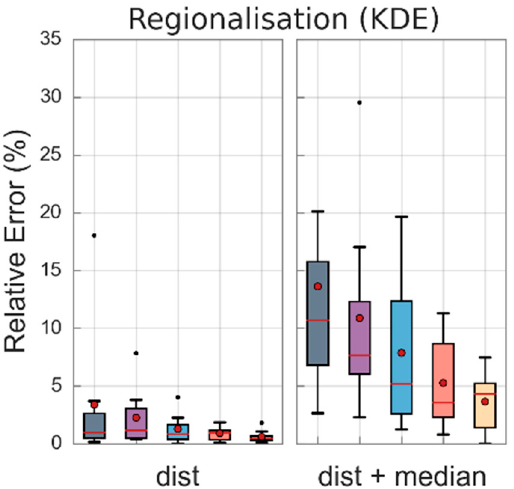
Figure 7. Distribution of relative errors in design flood estimates for each flood quantile across the eight study catchments using various methods to regionalize probability-distributed initial losses (parametric models). (Here, Beta and Gamma distributions are used to regionalize initial loss distri- bution).